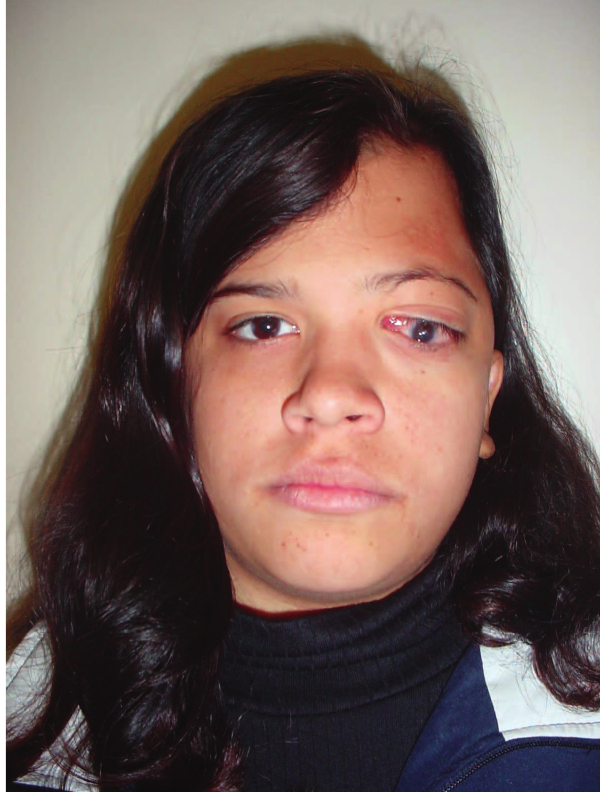
Figure 1 - Reported patient, now aged 18. Patient has given written authorization for the publication of this picture.